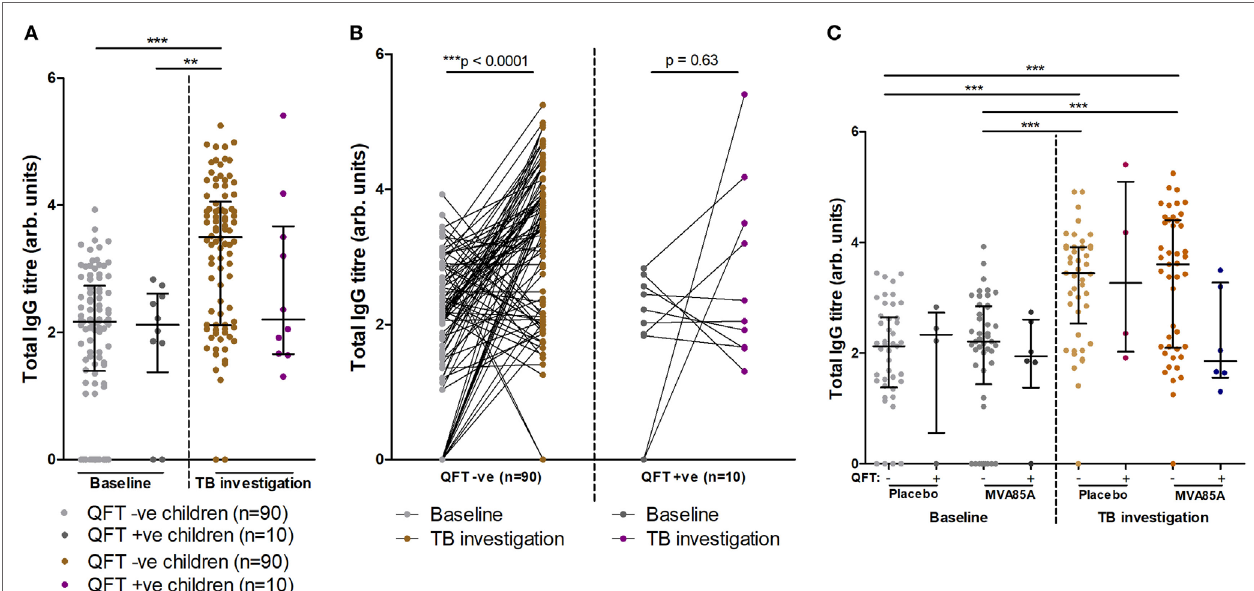
FigUre 3 | Total IgG titers stratified by QFT outcome and MVA vaccination status. Relationship between QFT outcome and total IgG titers from baseline and tuberculosis (TB) investigation participant samples (a) . A before/after comparison of samples subdivided as in (a) is presented in (B) . Relationship between QFT outcome, MVA85A vaccination status, and total IgG titers from baseline and TB investigation participant samples (c) . Column sample numbers left-right (c) : 45, 4, 45, 6, 45, 4, 45, 6. Antibody titers are presented as arbitrary values. Statistical analysis was performed with the Kruskal–Wallis test and Dunn’s post hoc test to assess significance of the comparisons in (a,c) . The Wilcoxon matched-pairs signed rank test was used to assess significance of the associations in (B)